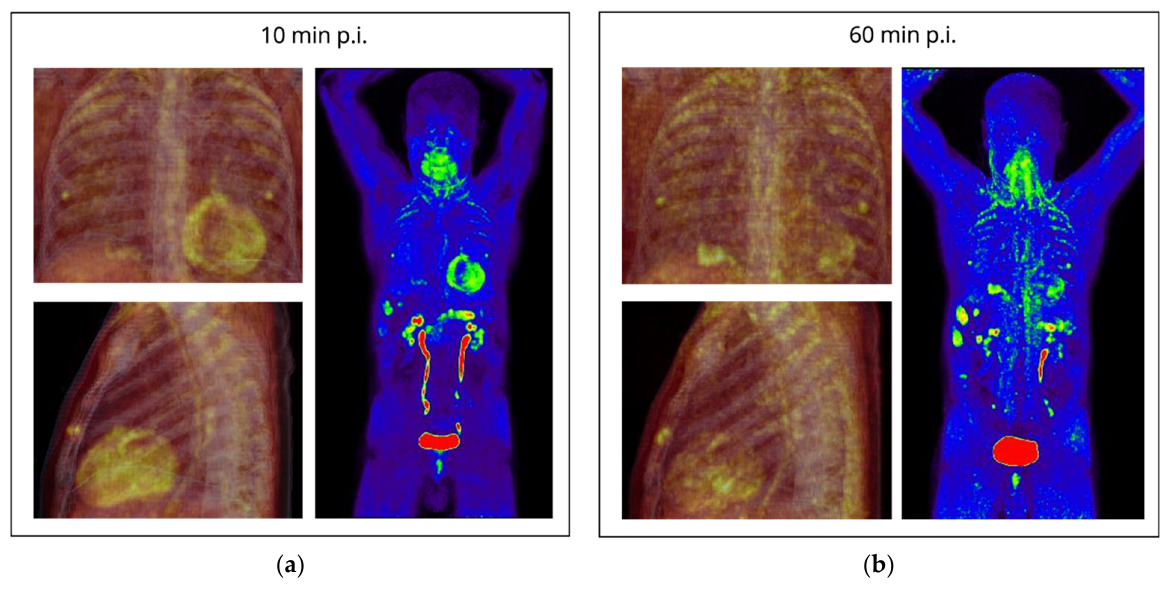
Figure 2. Example of a metastatic pancreatic ductal adenocarcinoma patient under distinct chemo- therapy regimens (gemcitabine/nab-paclitaxel followed by modified FOLFIRINOX). ( a ) Early 68 Ga-FAPI PET images 10 min p.i. ( b ) Late 68 Ga-FAPI PET images 60 min p.i. Clockwise from upper-left: PET/CT fusion anterior view, PET/CT fusion lateral view, PET maximum-intensity-projection an- terior view. Hybrid imaging shows the primary pancreatic carcinoma, multiple liver metastases, and peritoneal nodules (indicative of peritoneal carcinomatosis), each with intense FAP-expression. Chemotherapy-related cardiotoxicity was suspected due to increased cardiac FAP-expression (em- phasized in early images p.i.) and incomplete cardiac wash-out (observed in late images). PET/CT images were acquired at our